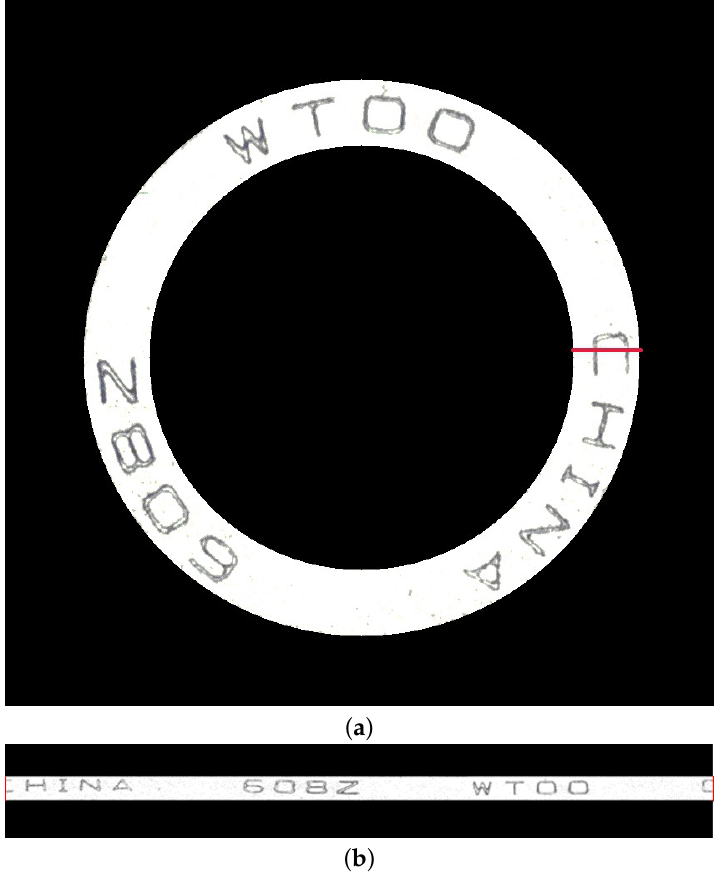
Figure 9. An instance of a character being cut. ( a ) The character in the dust cover crosses the polar axis. ( b ) The character is cut after